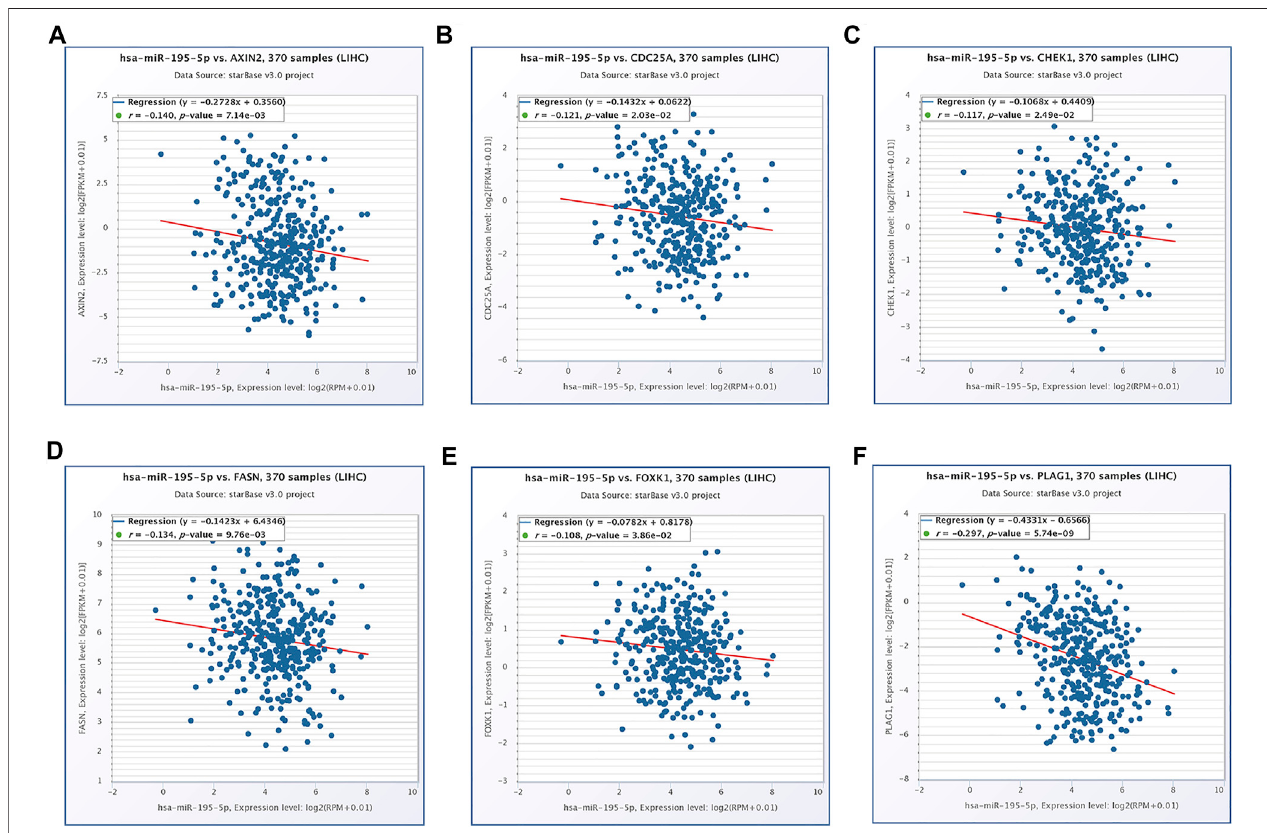
FIGURE 7 | The expression correlation of hsa-miR-195 – 5p with AXIN2 (A) , CDC25A (B) , CHEK1 (C) , FASN (D) , FOXK1 (E) , PLAG1 (F) .